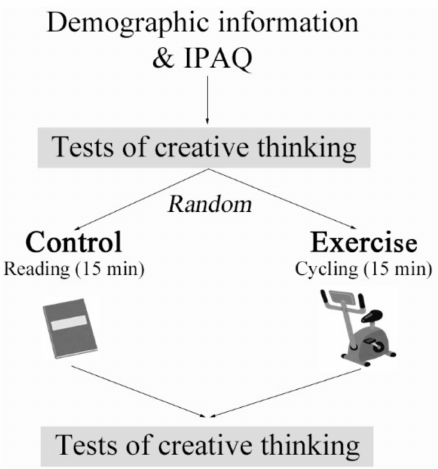
Figure 1. Schematic illustration of the procedure. Adapted from